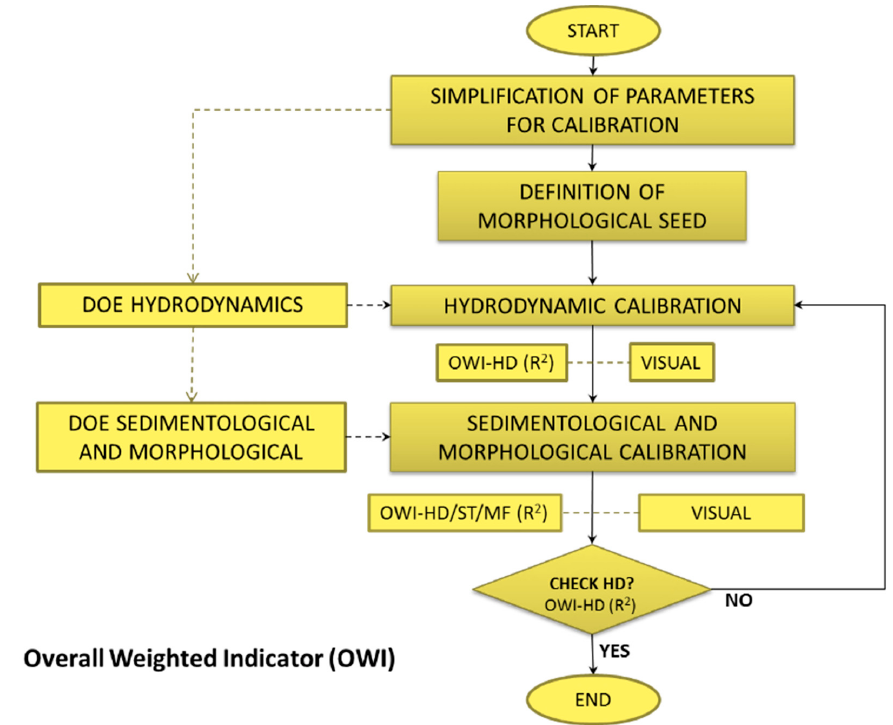
Figure 1 . Flowchart describing the calibration process. Figure 1. Flowchart describing the calibration